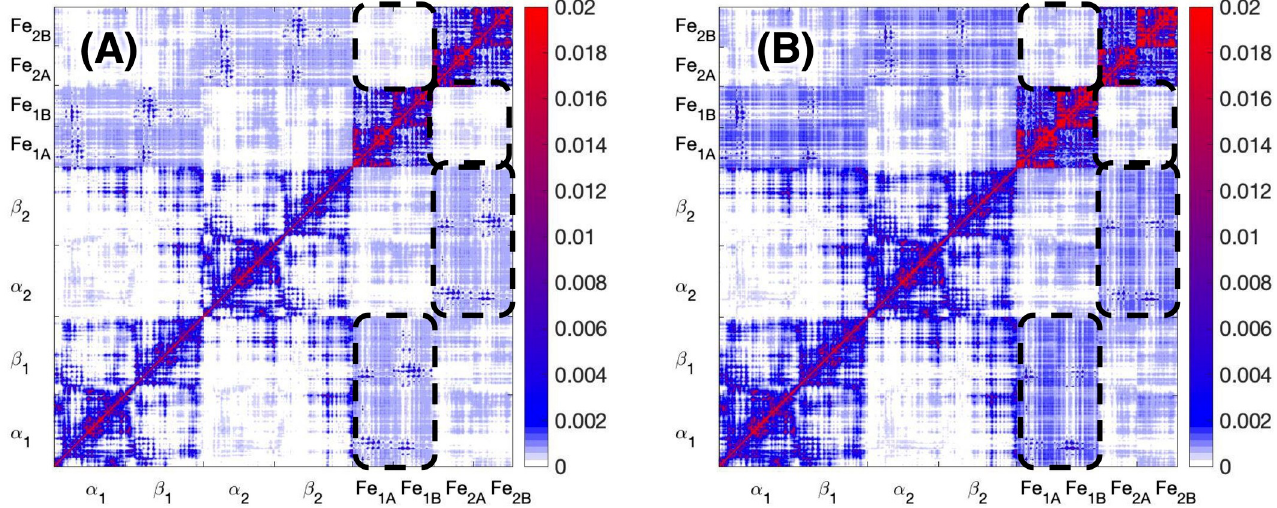
Fig 2. Mechanical coupling matrix M for (A) the ATP-bound nitrogenase complex and (B) the ADP-bound nitrogenase complex . The mechanical couplings between Fe 1 and α 1 β 1 , Fe 2 and α 2 β 2 , Fe 1 and Fe 2 are highlighted in dashed blocks.